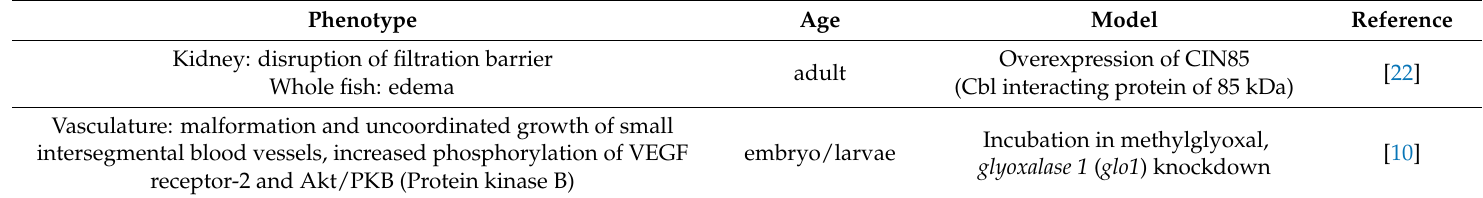
Table 2. Phenotypes found in normoglycemic zebrafish models related to diabetes mellitus